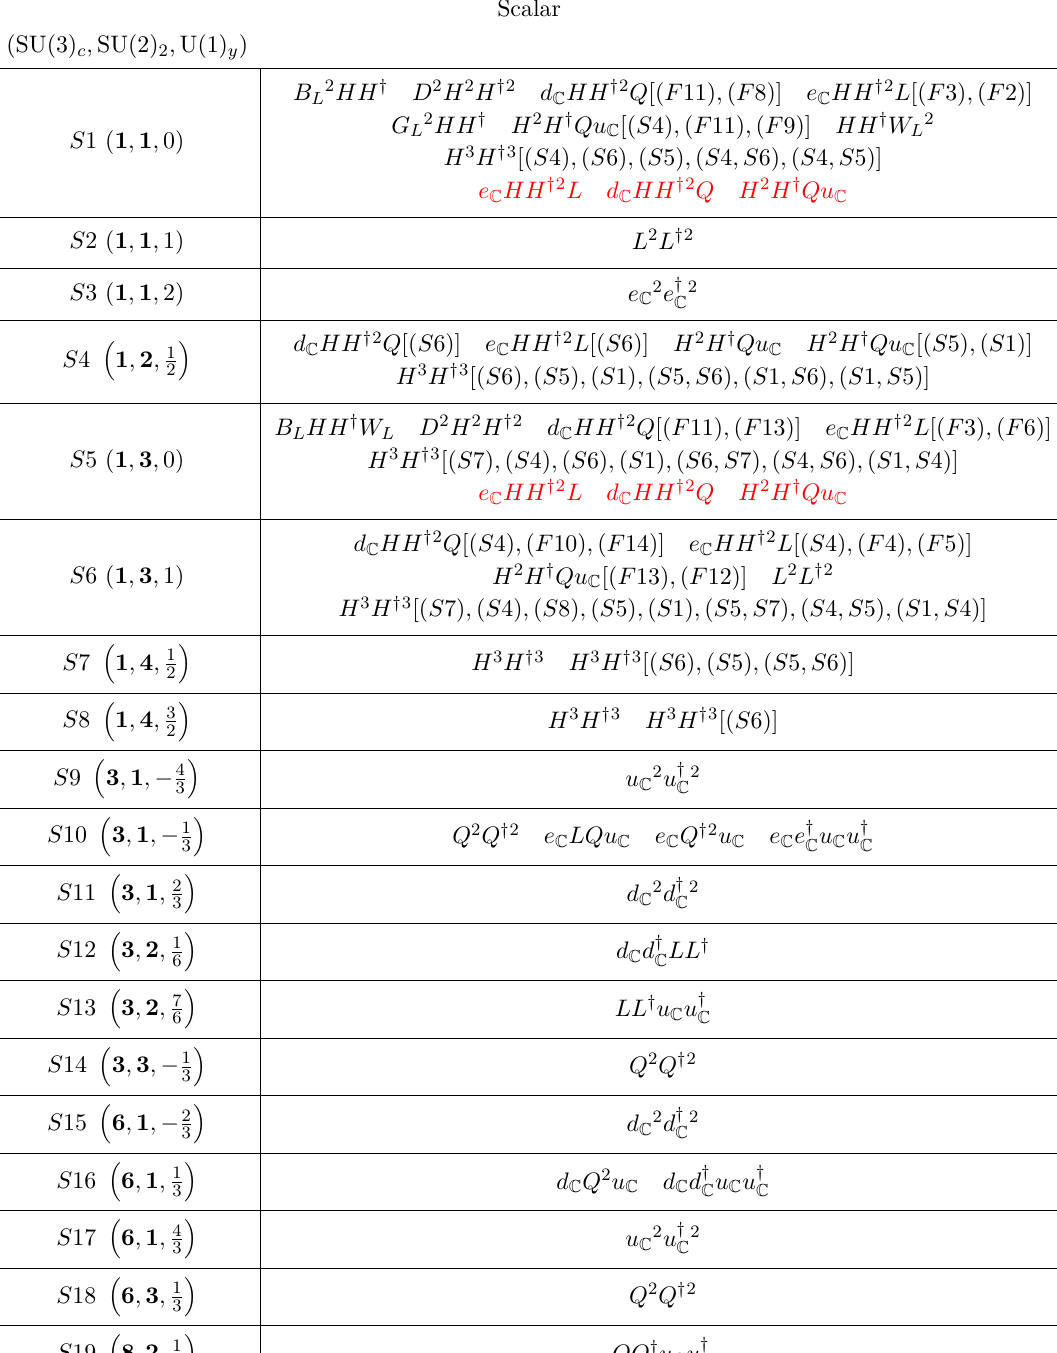
Table 15 . Scalar resonances which could generate the dim-6 operators. The name of the resonances is organized by the gauge quantum number. The resonance appeared in the squared bracket of the operator indicate that both resonances are needed to generate such